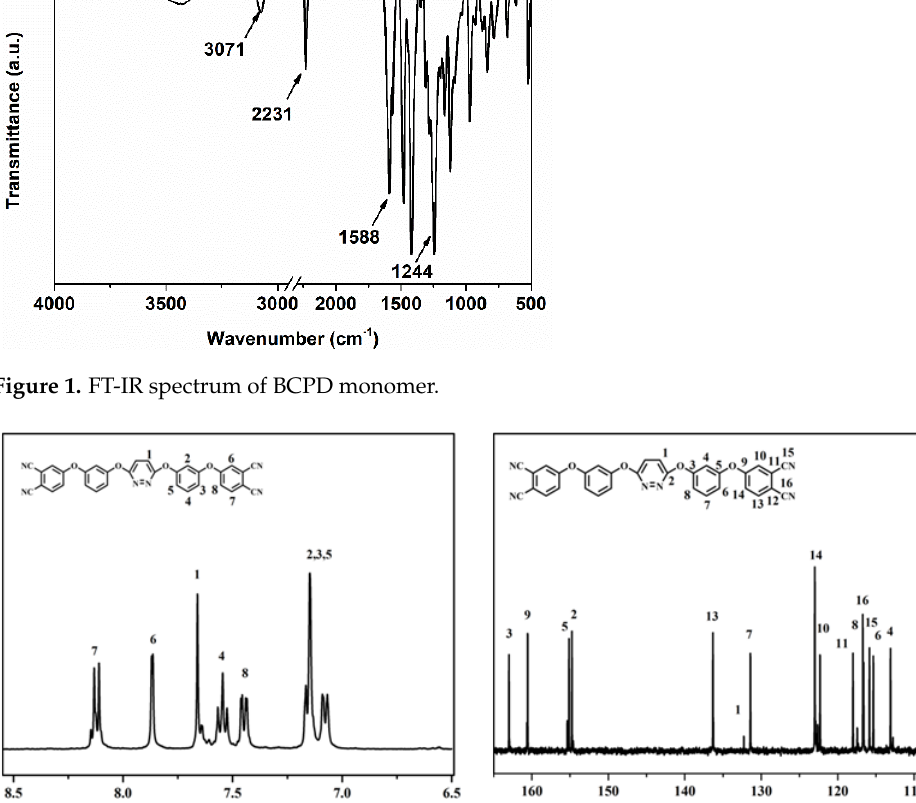
Figure 1. FT-IR spectrum of BCPD monomer.